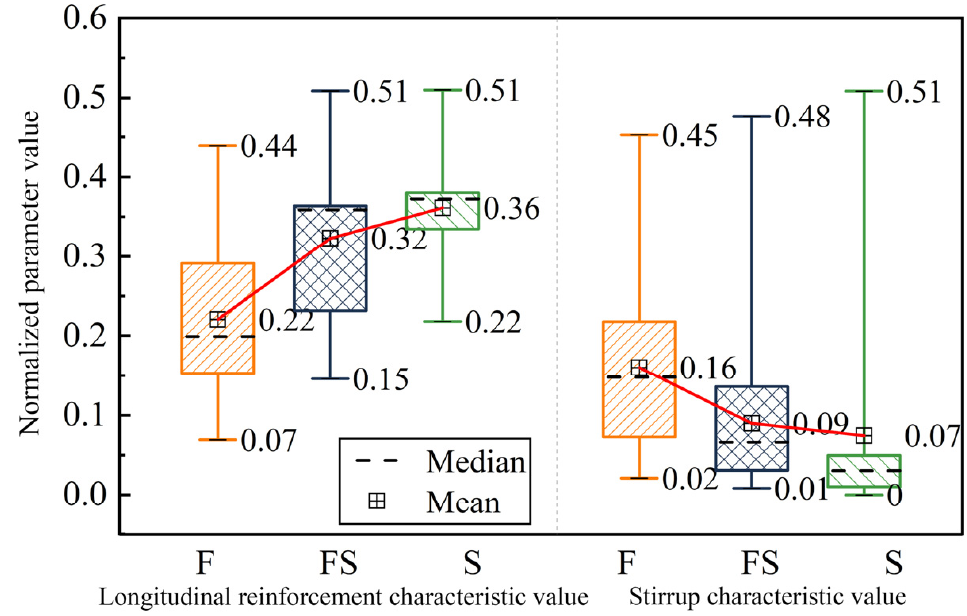
Figure 2. Distribution of reinforcement configuration in different failure modes.